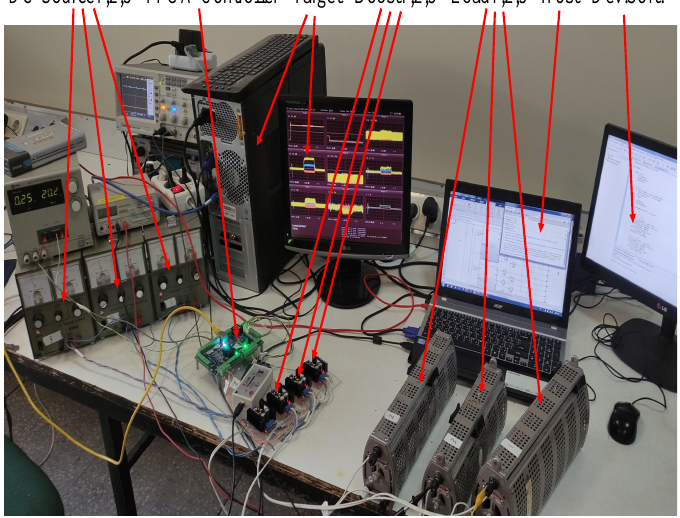
Figure 8. Experimental prototype for the validation of the proposed algorithm. This test-bench is composed of: development computer; host computer; target computer; Spartan 6 FPGA controller; three boost converters; three power supplies; three transmission loads, and a LAN